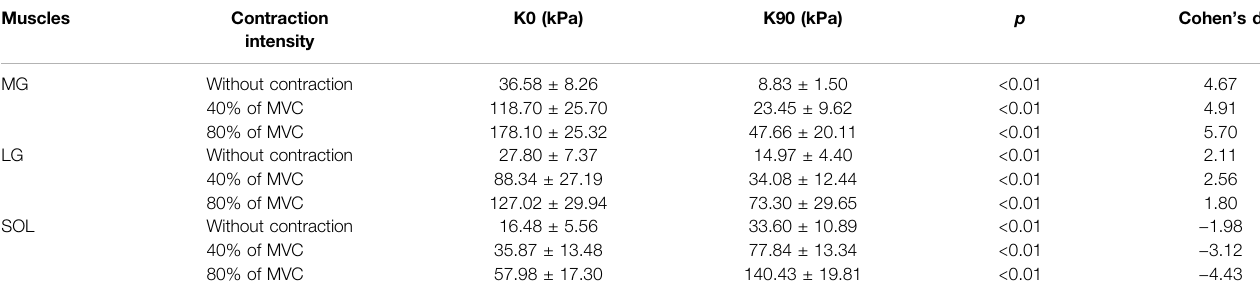
TABLE 1 | Shear modulus of the triceps surae muscle with different knee postures in different isometric contraction (plantar fl exion) intensity. Muscles